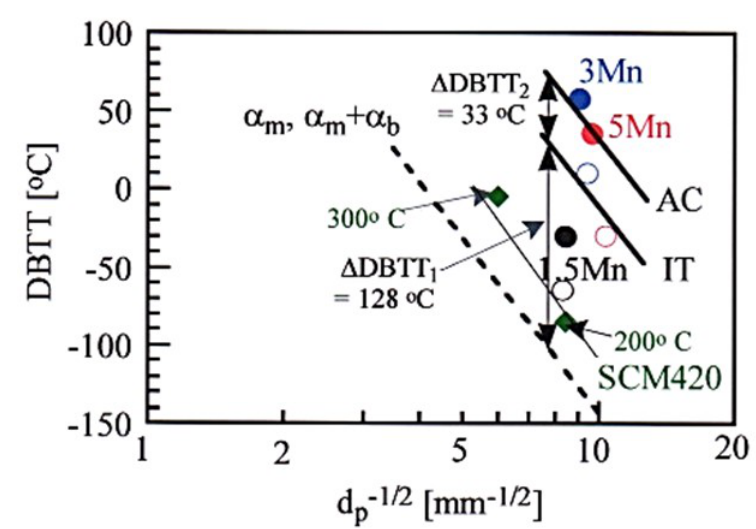
Figure 15. Relationship between 50% shear fraction ductile-brittle transition temperature (DBTT) and unit crack path ( d p ) for the 1.5 Mn ( ● ○ ), 3 Mn ( ● ○ ), and 5 Mn ( ● ○ ) steels subject to the AC (solid marks) and IT (open marks) processes and JIS-SCM420 ( ◆ ) steel quenched and then tempered at 200 °C and 300 °C. A dotted line represents the DBTT of 0.12%C-0.30%Si-0.83%Mn-0.30%Cu-1.11%Ni-0.53%Cr-0.49%Mo-0.03%V steel with the microstructure of martensitic ( α m ) or martensitic/bainitic ( α m + α b ) structures [45]. This figure is reproduced based on Ref. [21]. Copyright